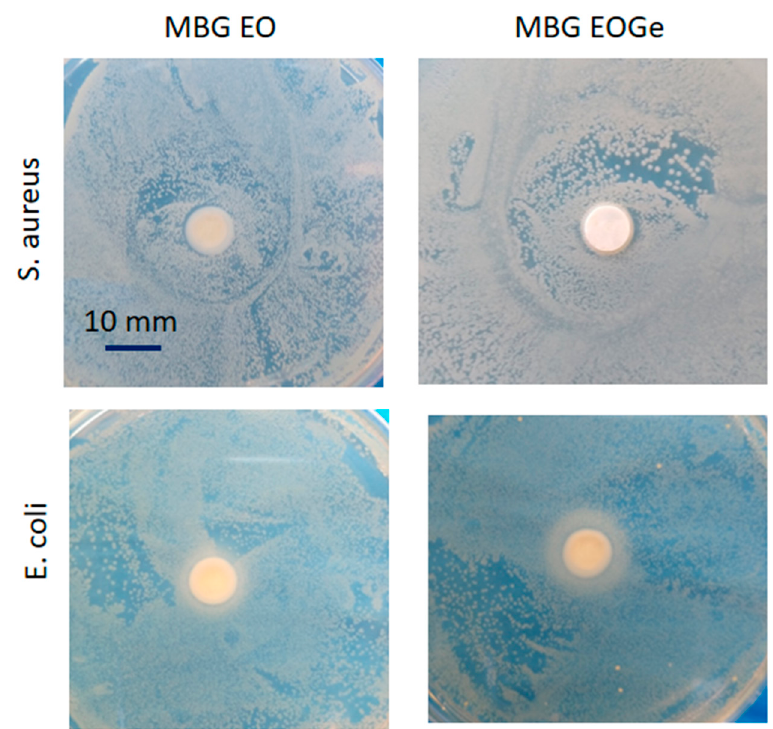
Figure 10. Agar diffusion test of the MBG EO and MBG EOGe pellets in contact with S. aureus and E. coli bacteria after 48 h growth.